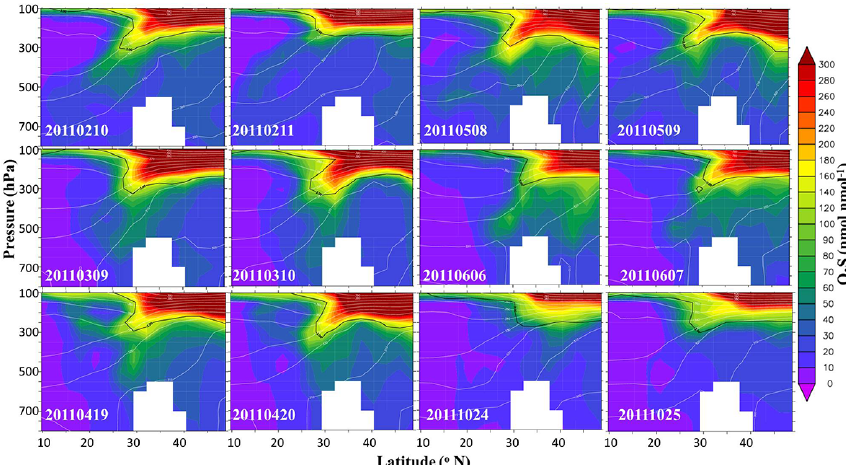
Figure 9. The latitude-pressure cross section of EMAC-simulated O 3 s at 79.5 ◦ E during all SOP days and a day before the event. White lines denote the potential temperature (K) and the black line denotes the dynamical tropopause at